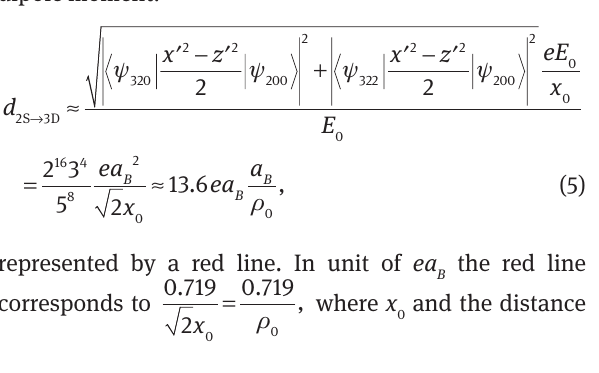
represented by a red line. In unit of ea corresponds to where x